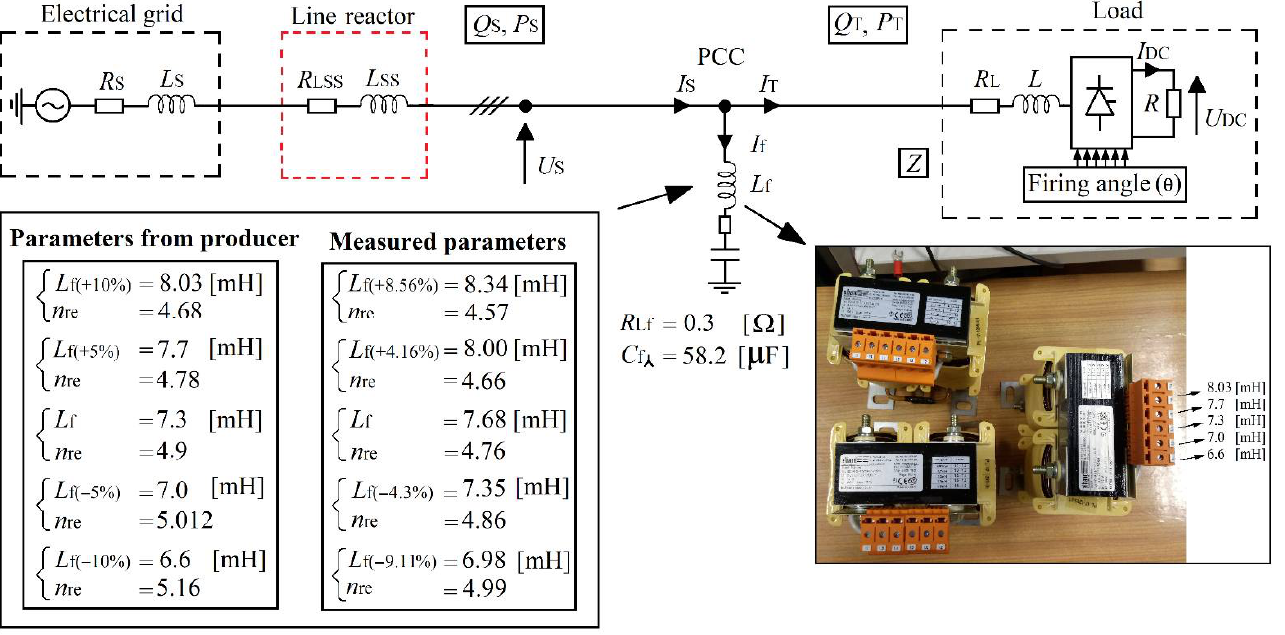
Figure 52. Power system equivalent circuit with filter reactor parameters.